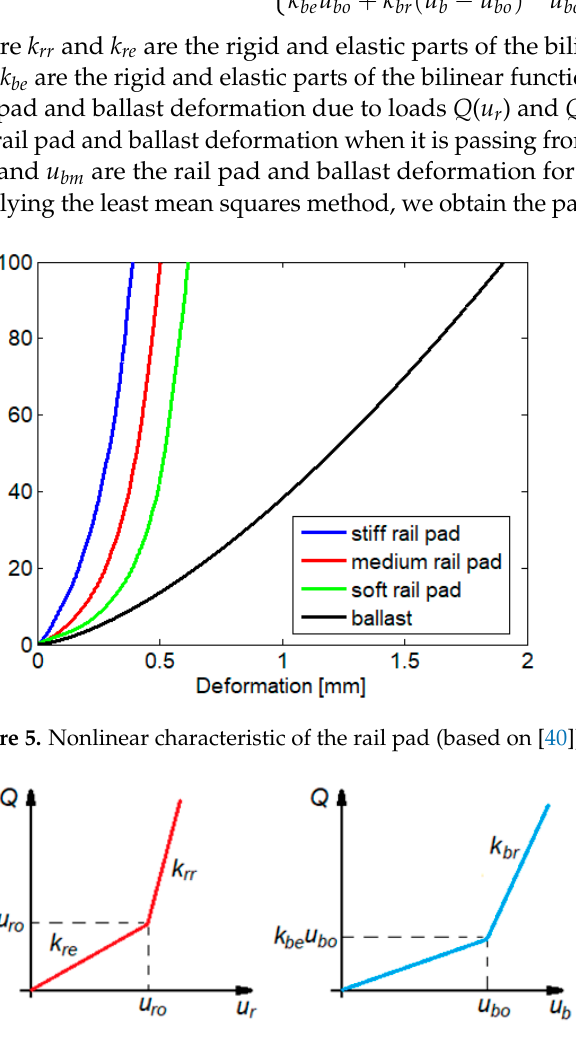
Figure 7. Bilinear approximation of the load-deformation characteristic: color code as in Figure 5; dotted lines – nonlinear function; continuous lines – bilinear approximation. Table 1 also contains the values of the stiffnesses of the two elastic layers calculated depending on a sleeper bay of 0.577 m: 1